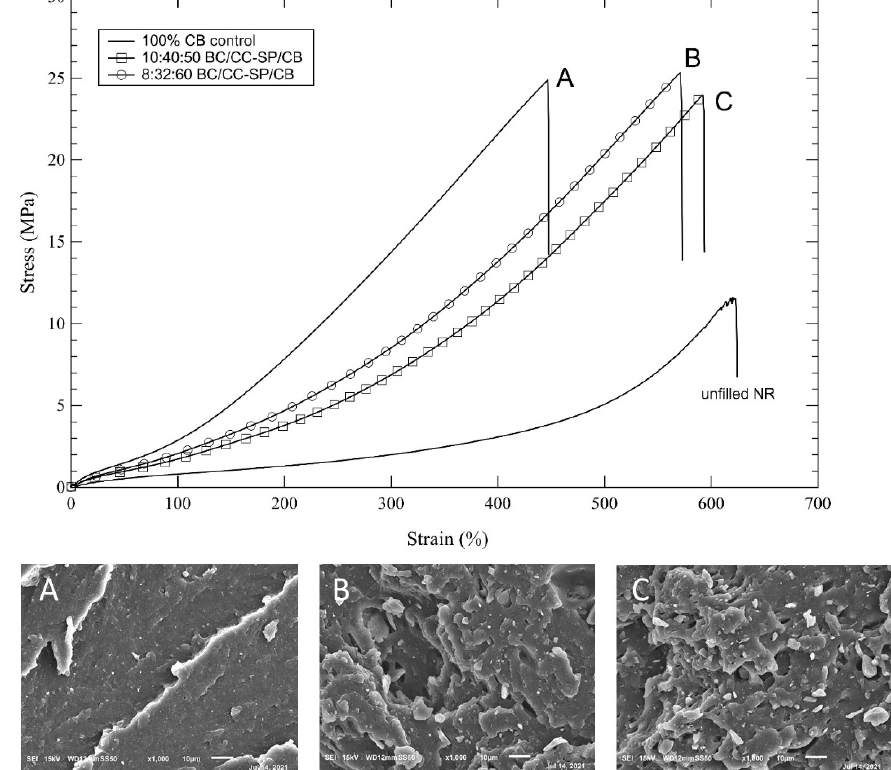
Figure 4. Tensile properties for: ( A ) 100% CB filled control, ( B ) 8:32:60 BC/CC-SP/CB, and ( C ) 10:40:50 BC/CC-SP/CB. Additionally included are SEM images at 1000 × of the three composite samples along their fractured surface after tensile testing. The small white bar in the lower right section of each SEM image represents 10 microns.